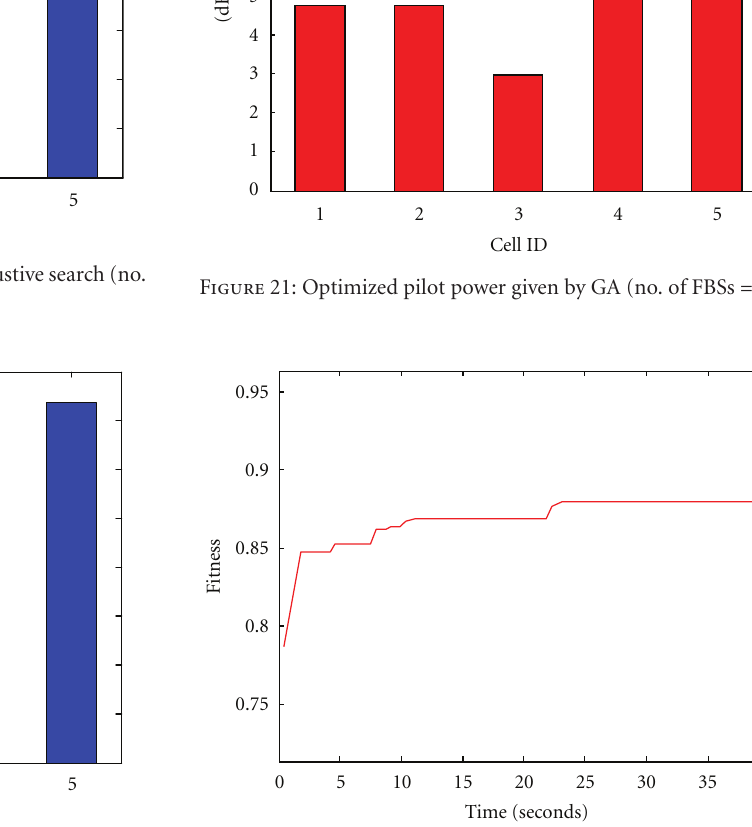
Figure 19: Load handled by the femtocells in GA (no. of FBSs = 5).